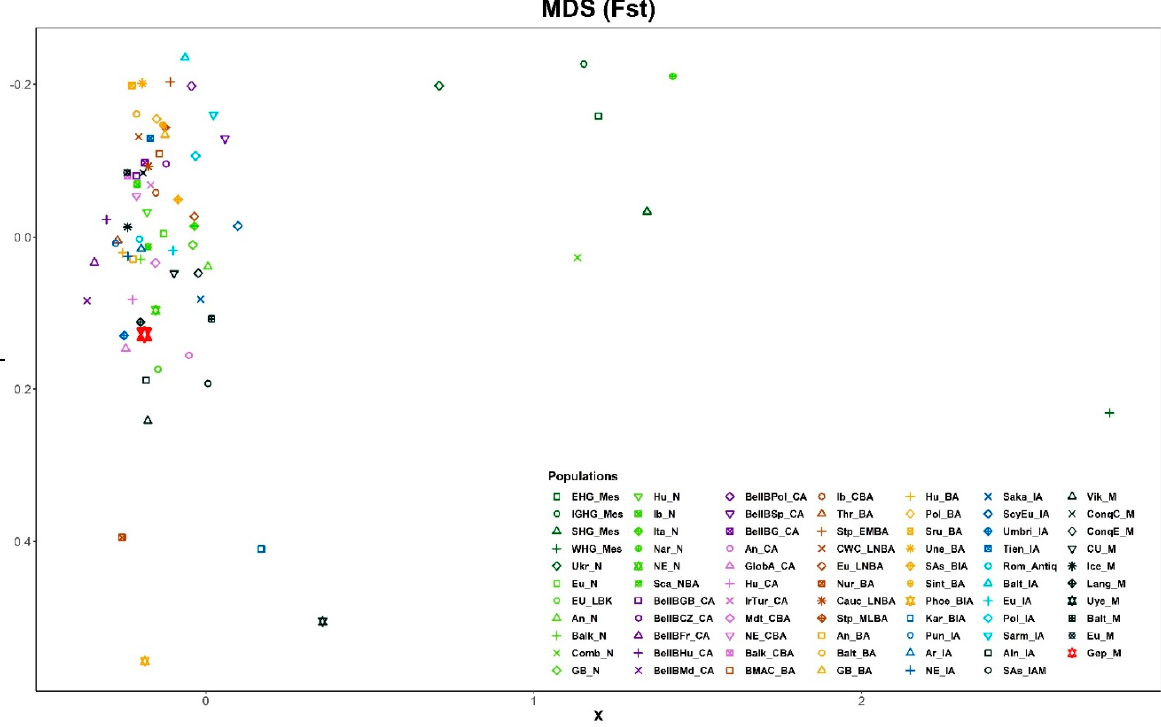
Figure 4. A multi-dimensional scaling (MDS) plot from the linearized Slatkin Fst values of Table S5a. For better resolution 14 Asian populations were left out from the analysis. The abbreviations of the population names are given in Table S4.